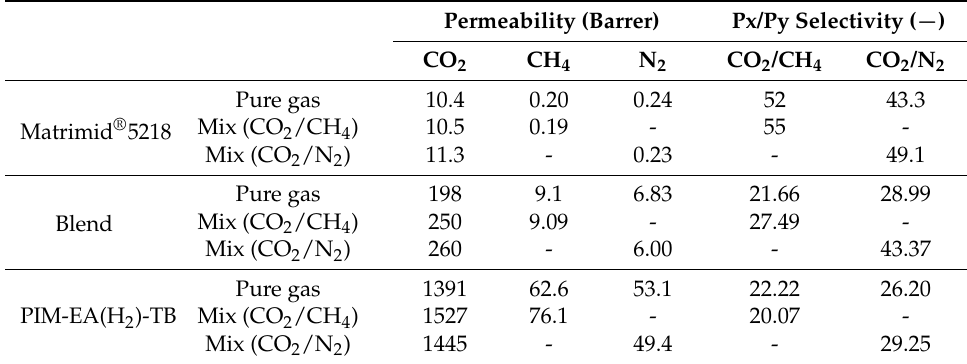
Comparison of the pure and mixed gas permeability of the neat Matrimid ® 5218, PIM-EA(H 2 )-TB and their blend membrane as measured in the mixed gas setup. Feed gas: